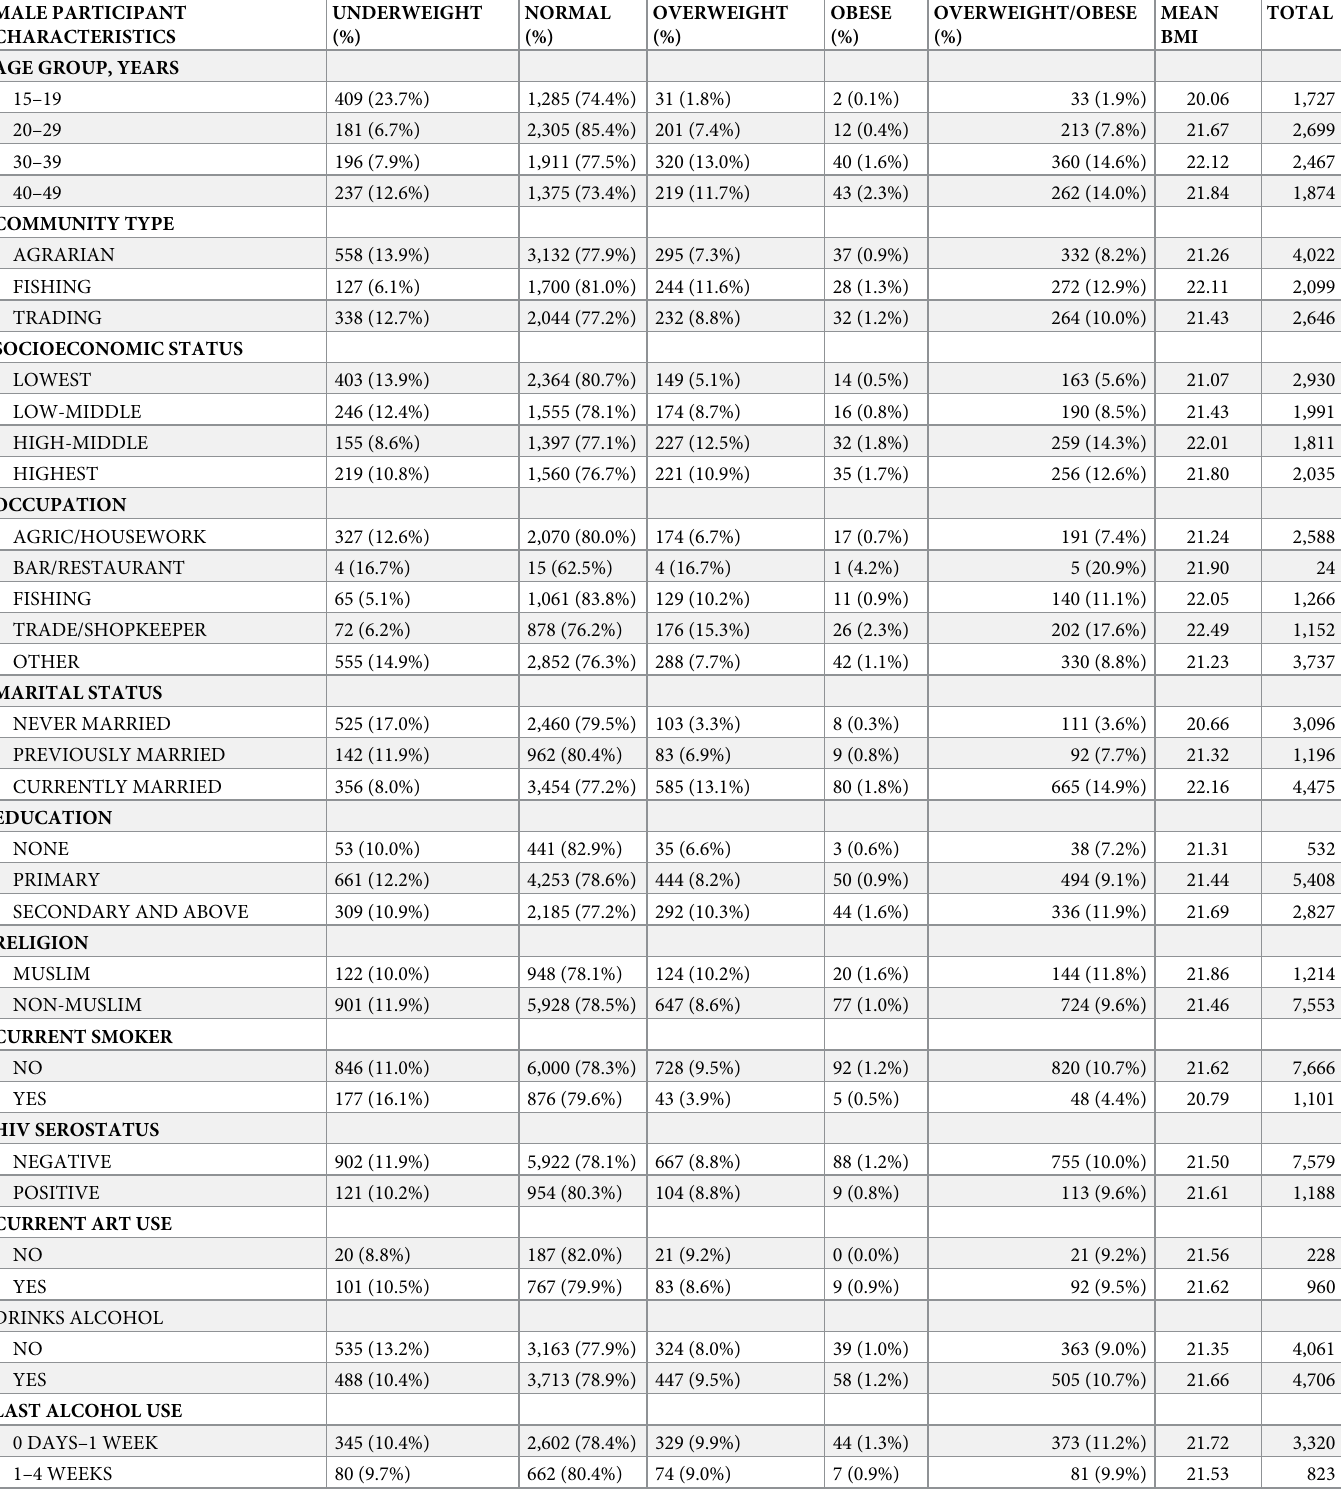
Table 3. Male population by BMI category over sociodemographic characteristics, including mean